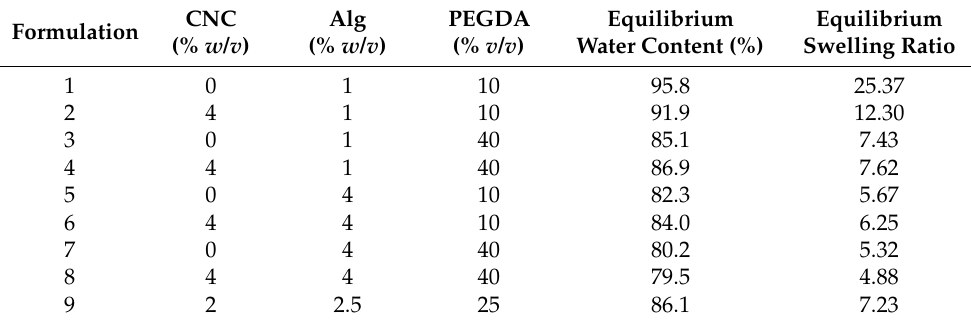
Table 3. Water Content and Swelling Ratio of CNC/Alg/PEGDA 3D